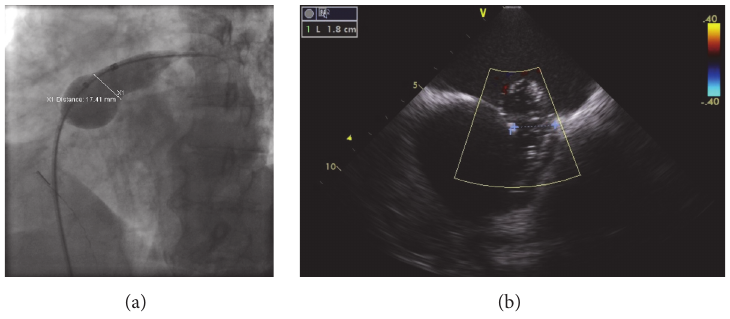
Figure 3: (a) Resizing of the ASD using the sizing balloon. (b) Resizing of the ASD using the intracardiac